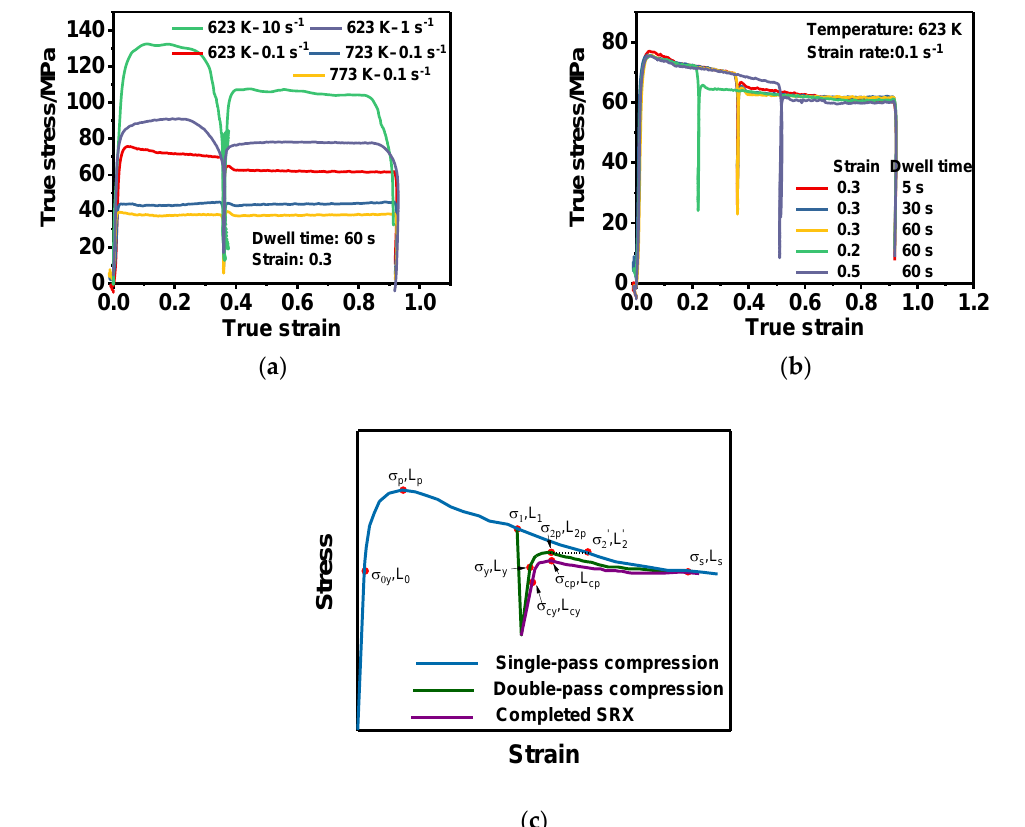
Figure 3. True stress–strain curves under the condition of ( a ) different temperatures and strain rates at the same dwell time and strain; ( b ) different dwell times and strains at the same temperature and strain rate; ( c ) single-pass, double-pass, and completed static recrystallization (SRX) compression.